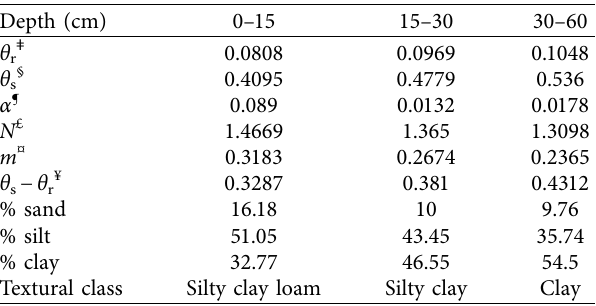
Table 1: van Genuchten equation parameters from 2014, per- centage (sand, silt, and clay), and soil textural class for three soil depths at the TVREC. The parameters from 2014 were used during both growing seasons.